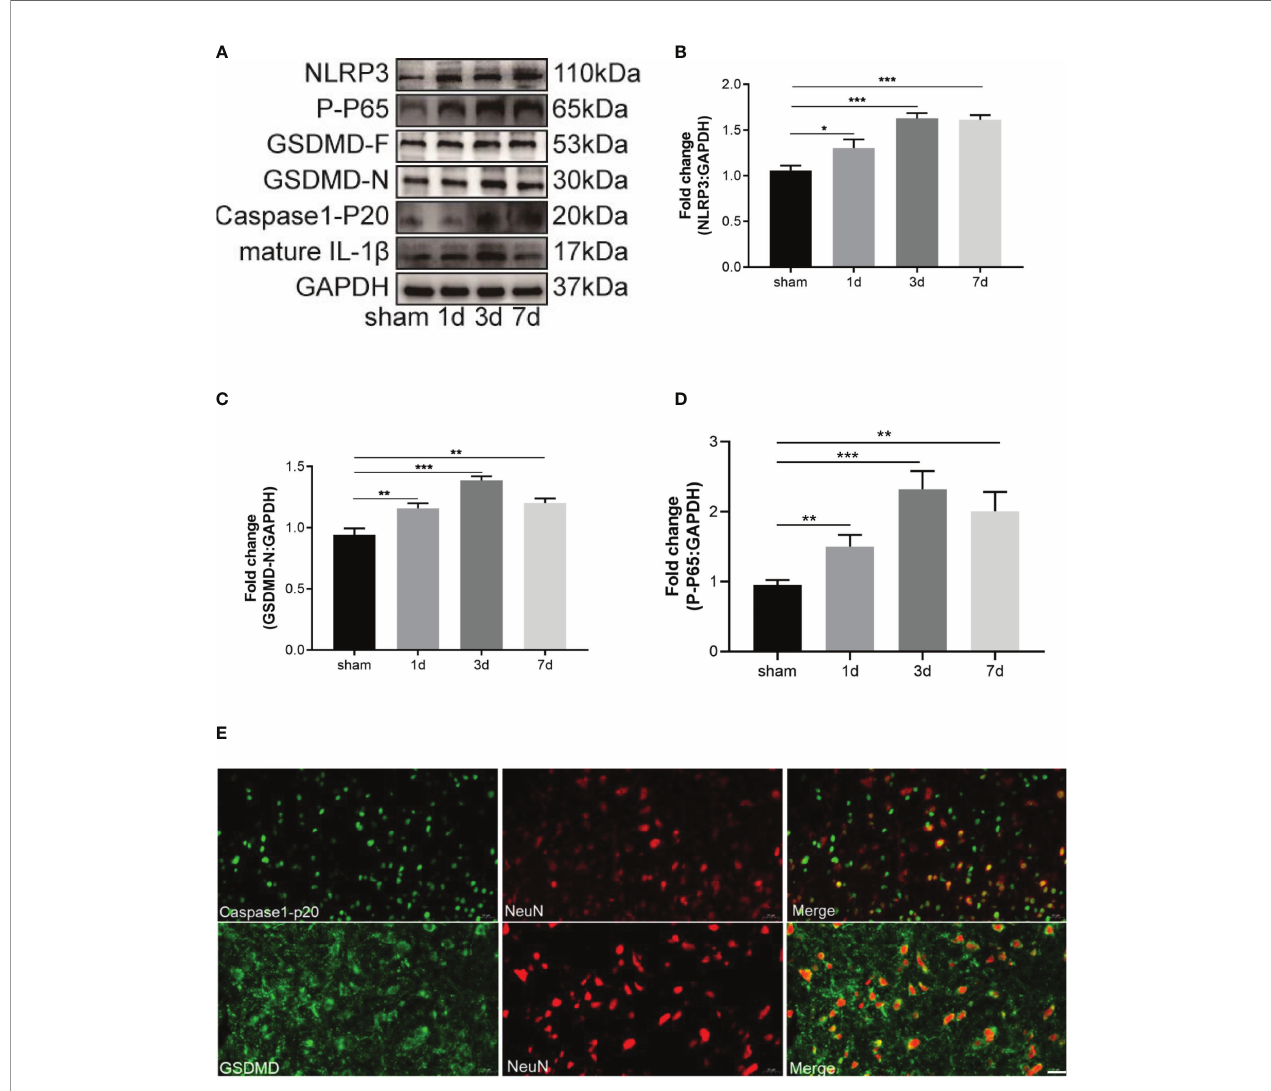
FIGURE 3 | CFA-induced in fl ammatory pain induced neuronal pyroptosis through activating NF- k B. (A) Western blots of pyroptosis-related proteins, including NLRP3, GSDMD-F and GSDMD-N, caspase-1-P20, mature IL-1 b . The activation of NF- k B signal transduction was tested by western blot of P-P65. (B – D) Subsequent quantitative analysis of NLRP3, GSDMD-N, P-P65 expression, n=4 mice/group. (E) Double immuno fl uorescence staining of GSDMD and caspase-1- P20 with neuron marker NeuN, Bar=20 µm, n=4 mice/group. Data were presented as mean ± standard deviation (SD). (*P < 0.05, **P < 0.01, ***P <